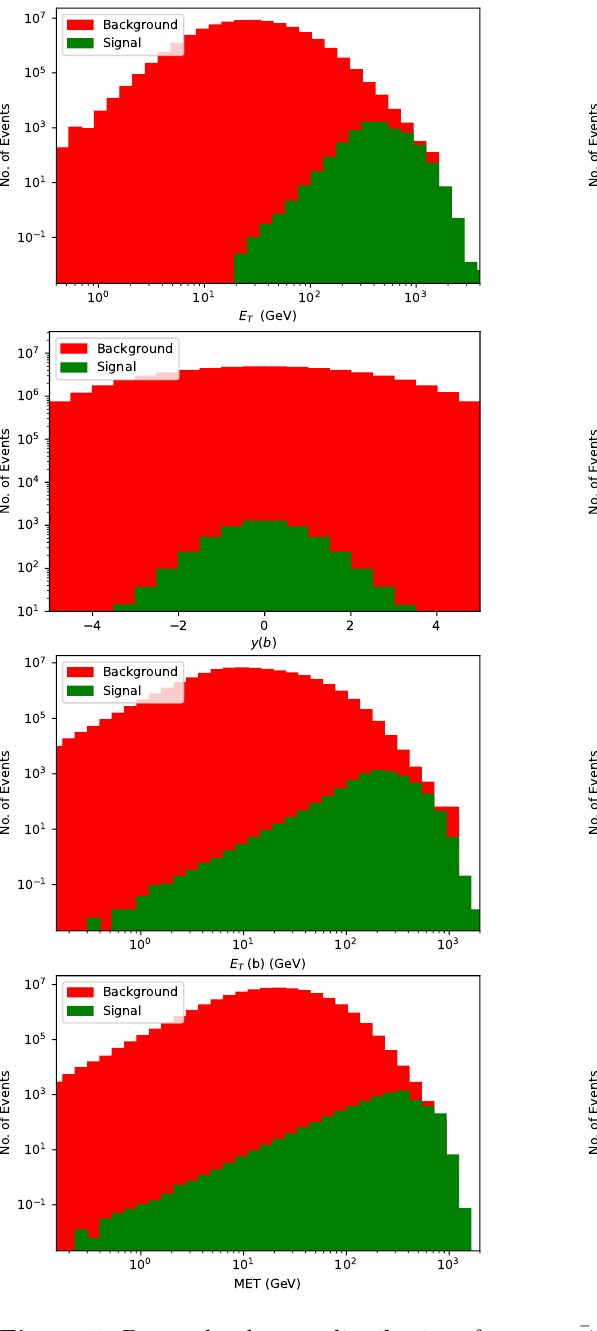
H 0 /A 0 A 0 for BP1 normalized to 1 1 1 1 , T